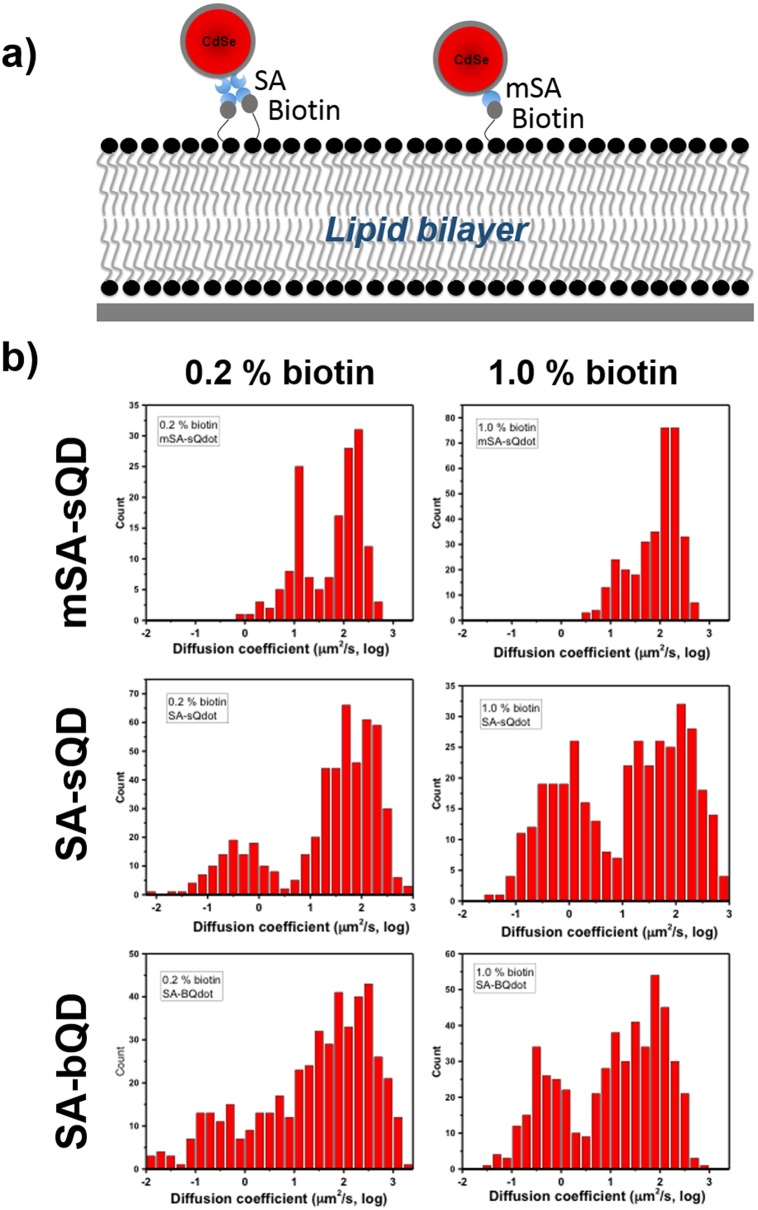
Measuring the diffusion coefficient of labeled qdots on the lipid bilayer in order to examine the possibility of cross-linking.(a) represents the schematics of cross-linking of streptavidin(SA) conjugated qdots. SA conjugated qdots have more chance to cross-link multiple target molecules on a single qdots because a SA has four binding sites, but a monomeric SA has only one binding site. Thus, monomeric streptavidin intrinsically excludes binding multiple molecules on a single qdot. (b) histograms of diffusion coefficients measured at different conditions which are at 0.2% and 1.0% biotin concentration of lipid bilayer using three different qdots, such as SA-Bqdot(commercial qdots), SA-small qdots, and monomeric SA-small qdots.